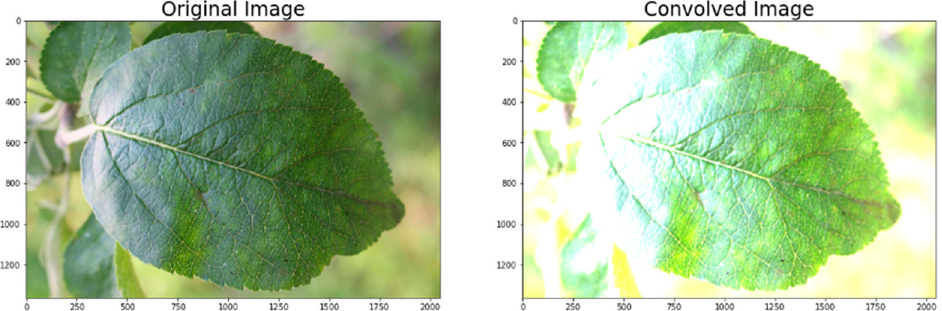
Figure 13. Output of convolution.